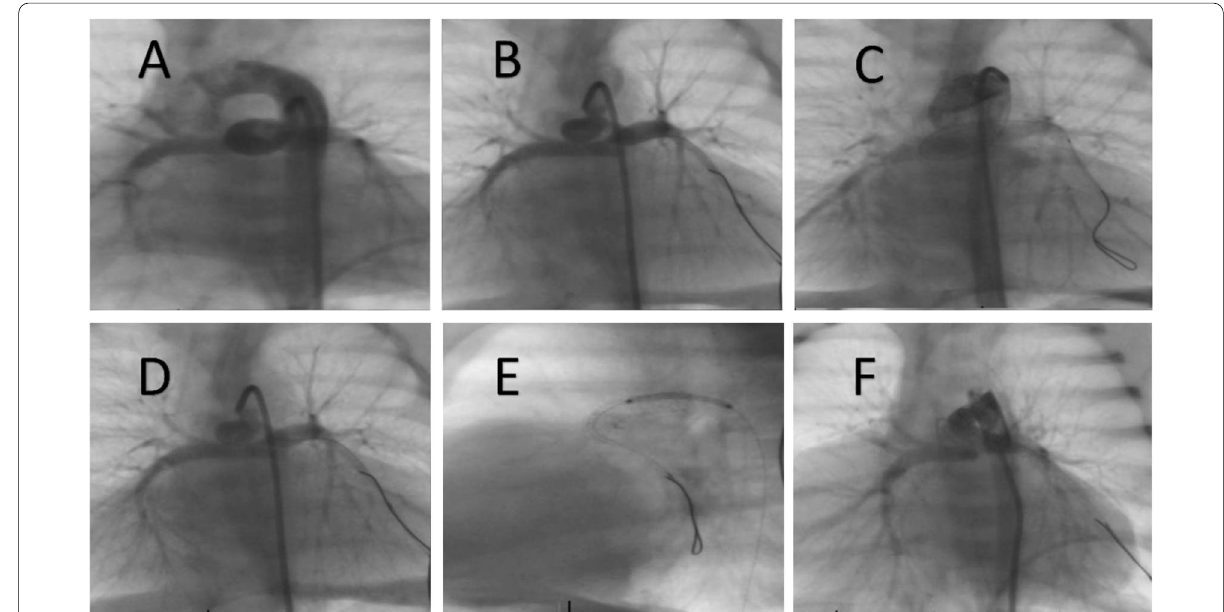
Fig. 5 Stenting a convoluted duct. The upper panel images ( A – C ) show the tortuous duct with the wire taking the same complete circle of the duct. The wire was manipulated to straighten the duct ( D ). Two stents were used to cover the whole length of the duct ( E – F